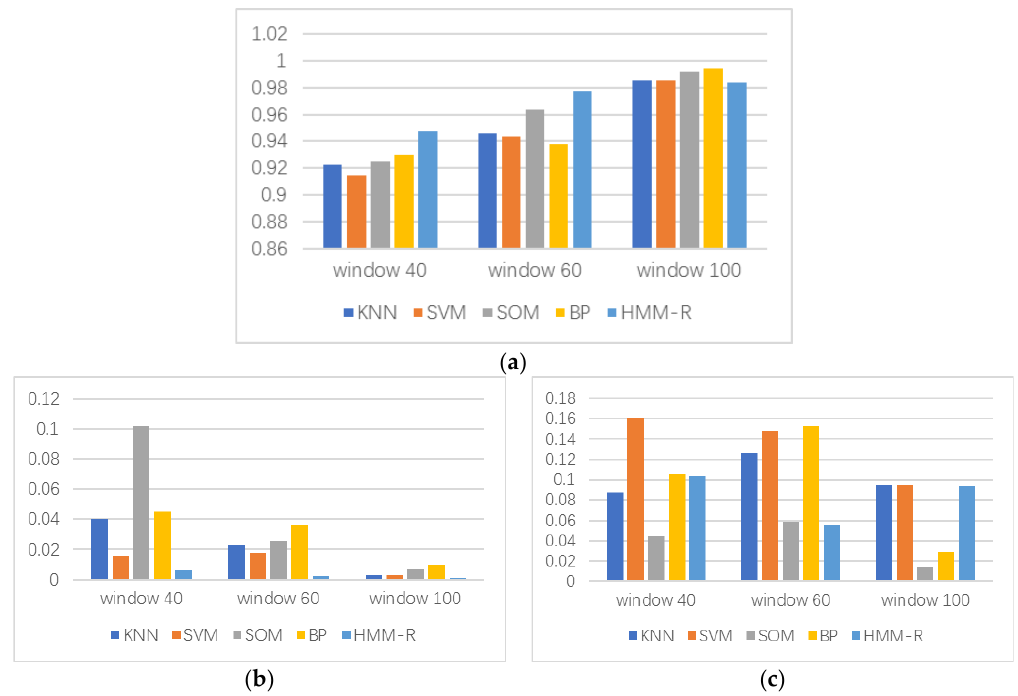
Figure 5. Comparison diagram of performance Indices of algorithms at attack ratio of 0.025. ( a ) Comparison of RP of algorithms; ( b ) comparison of FA of algorithms; ( c ) comparison of DR of algorithms.